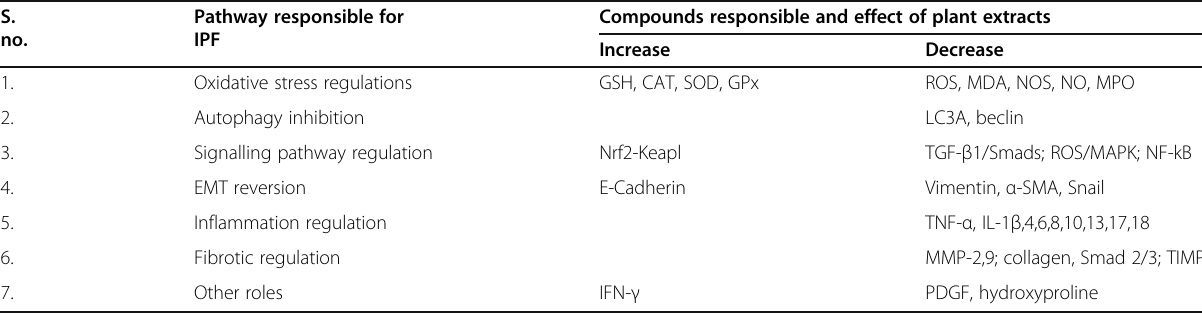
Table 4 The therapeutic effect of plants on various factors and pathways leading to IPF S.